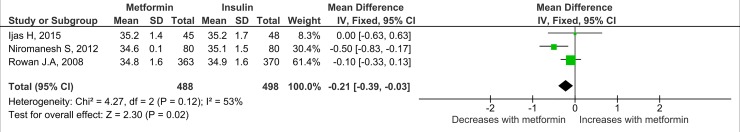
Neonatal head circumference.Expressed as mean difference (fixed effects model) and 95% CI. IV, mean difference.